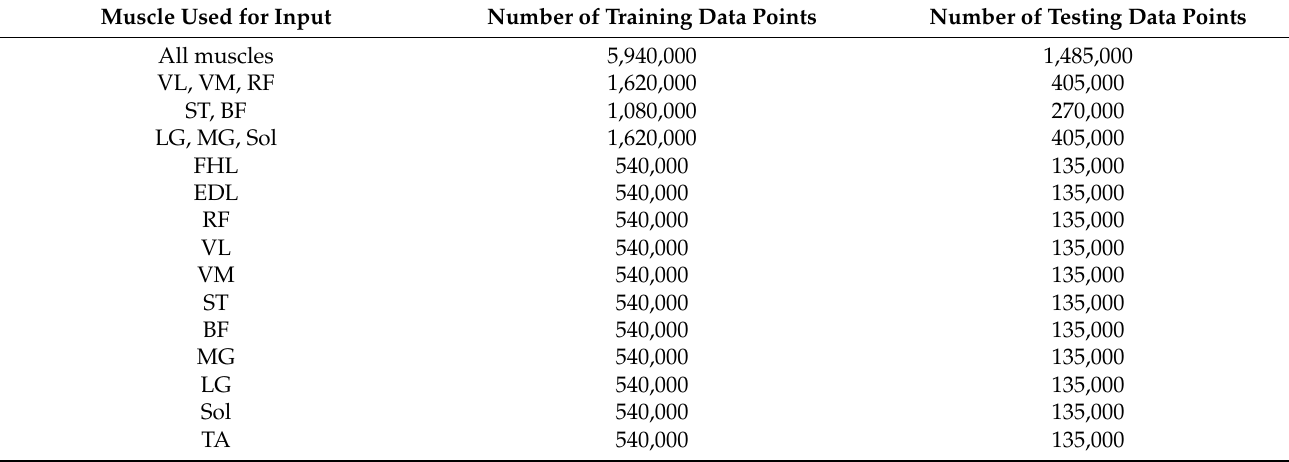
Table A1. The number of input data points used for training and testing each model. Muscle Used for